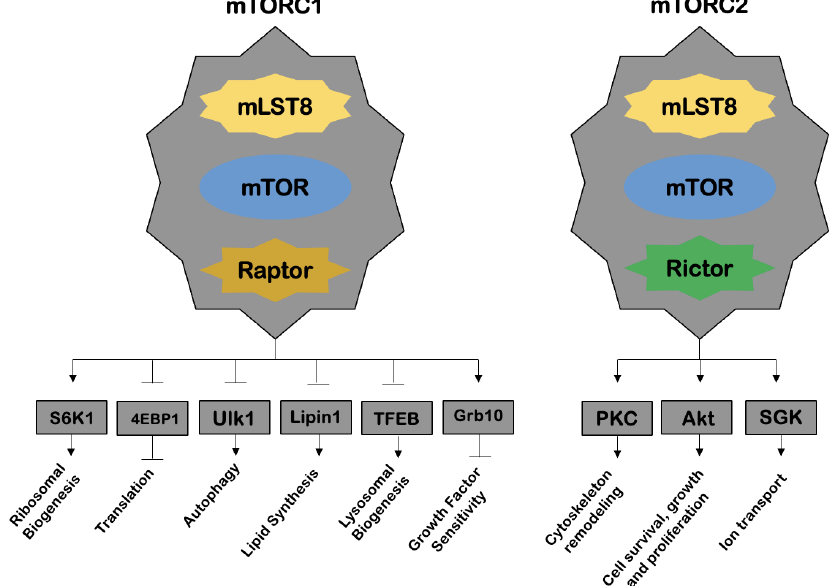
Figure 3. mTOR complex 1 (mTORC1) and 2 (mTORC2) components (adapted from Melick et al. [14]). The arrows represented in the figure refer to the stimulatory capacity of the complexes and, the bars represent an inhibitory capacity. Abbreviations: mTORC1: mTOR, kinase